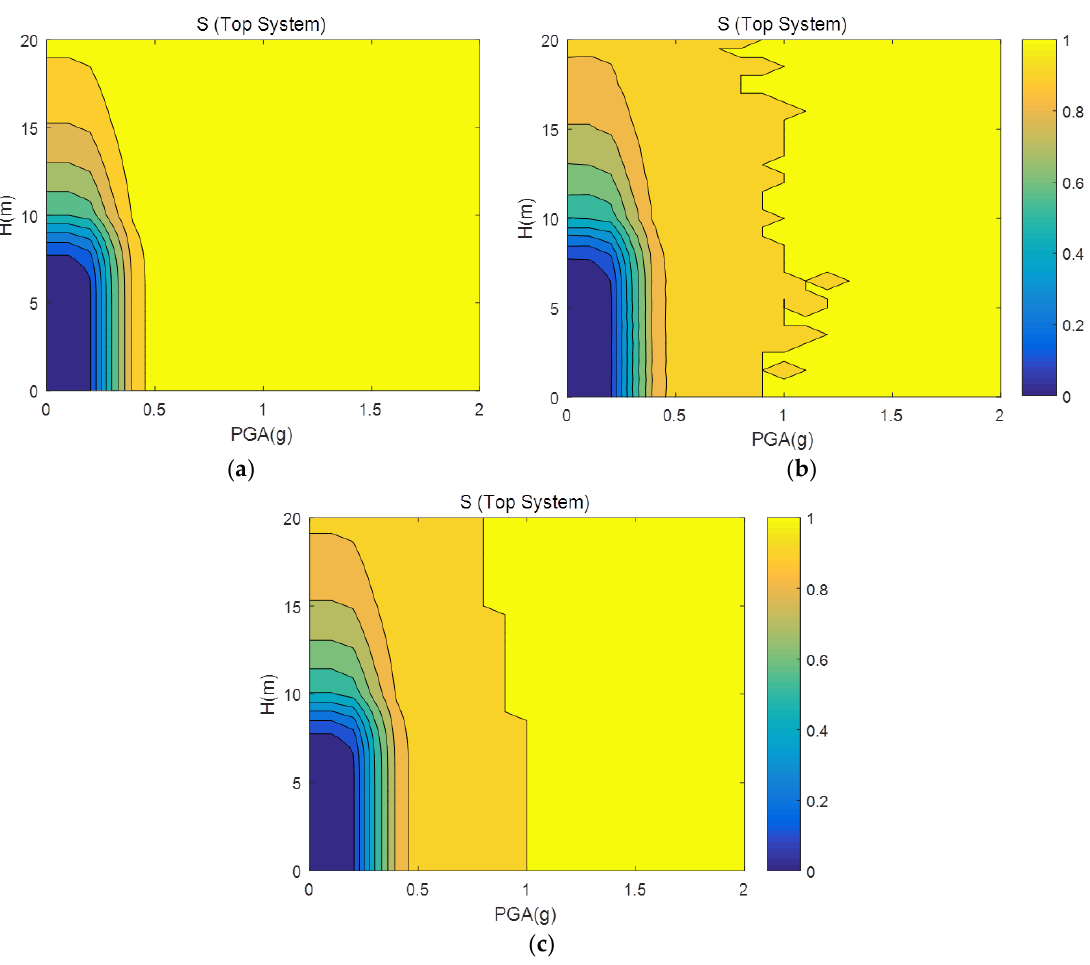
Figure 5. Comparison of the multi-hazard system fragility results regarding the example C1 ∩ C2 ((2) fully dependent condition)): ( a ) Boolean; ( b ) E-DQFM; ( c ) proposed (I-DQFM).